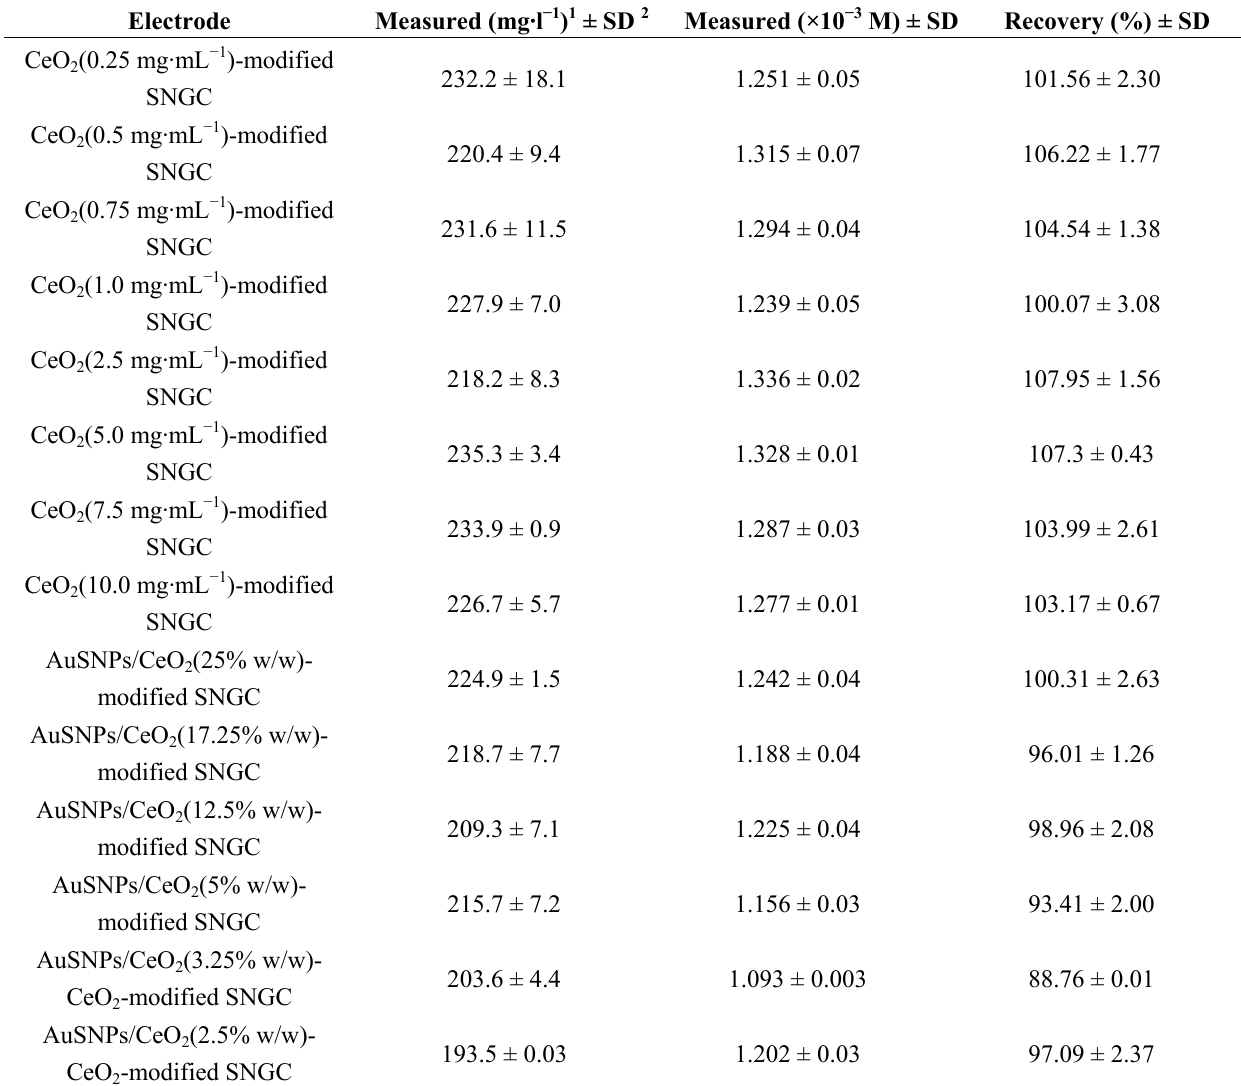
Table 5. Experimental results for the determination of the content of AA in apple juice for babies by using the standard addition